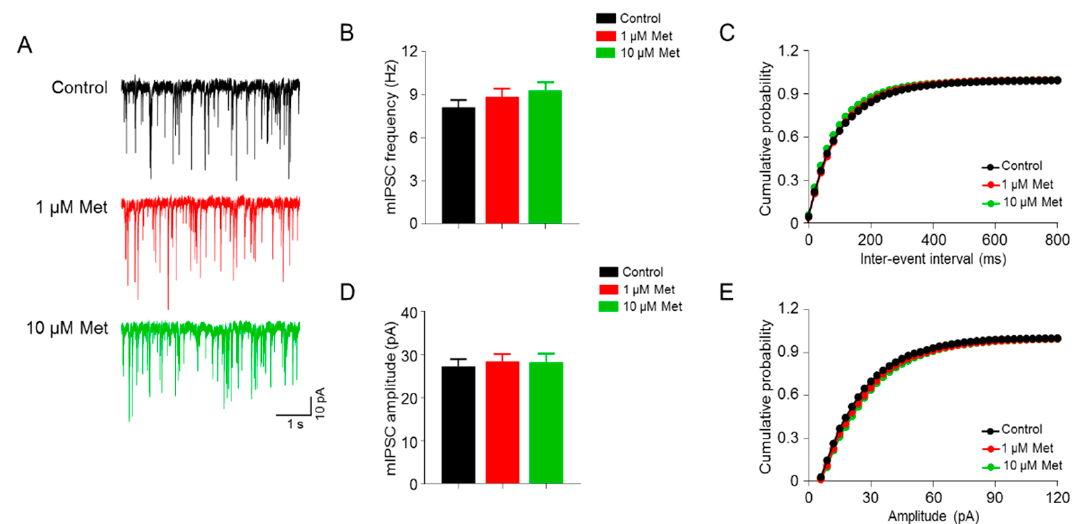
Figure 2. Inhibitory transmission was not altered in Met-treated hippocampal slices. ( A ) Representative traces showing miniature inhibitory postsynaptic currents (mIPSCs) in CA1 pyramidal neurons incubated with 0, 1 and 10 µ M Met. Scale bar = 1 s, 10 pA. ( B ) No di ff erence in mIPSC frequency of pyramidal neurons among groups. n = 17–18 neurons from four mice per group. F(2,49) = 1.085, p = 0.3458, control (8.12 ± 0.51 Hz) versus 1 µ M Met (8.86 ± 0.57 Hz), p = 0.6155; control (8.12 ± 0.51 Hz) versus 10 µ M Met (9.28 ± 0.60 Hz), p = 0.3220; 1 µ M Met (8.86 ± 0.57 Hz) versus 10 µ M Met (9.28 ± 0.60 Hz), p = 0.8569; one-way ANOVA followed by Tukey’s post hoc test. ( C ) Cumulative probability curves for mIPSC inter-event interval. Control versus 1 µ M Met, p = 0.9206; control versus 10 µ M Met, p = 0.5886; 1 µ M Met versus 10 µ M Met, p = 0.9898; Kolmogorov–Smirnov test. ( D ) No di ff erence in mIPSC amplitude of pyramidal neurons among groups. n = 17–18 neurons from four mice per group. F(2,49) = 0.1204, p = 0.8869, control (27.29 ± 1.70 pA) versus 1 µ M Met (28.43 ± 1.67 pA), p = 0.8921; control (27.29 ± 1.70 Hz) versus 10 µ M Met (28.28 ± 1.99 pA), p = 0.9206; 1 µ M Met (28.43 ± 1.67 pA) versus 10 µ M Met (28.28 ± 1.99 pA), p = 0.9978; one-way ANOVA followed by Tukey’s post hoc test. ( E ) Cumulative probability curves for mIPSC amplitude. Control